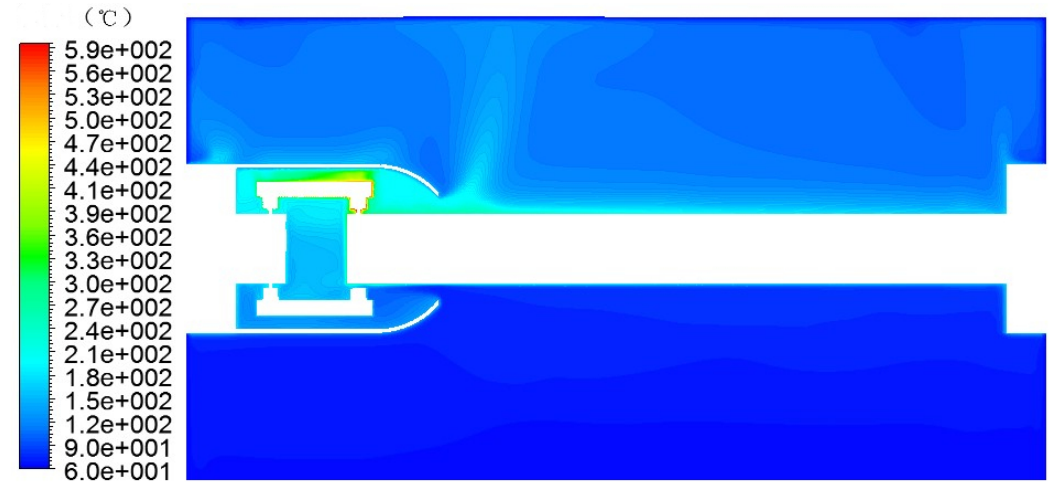
Figure 7. GIS flow-field velocity cloud.